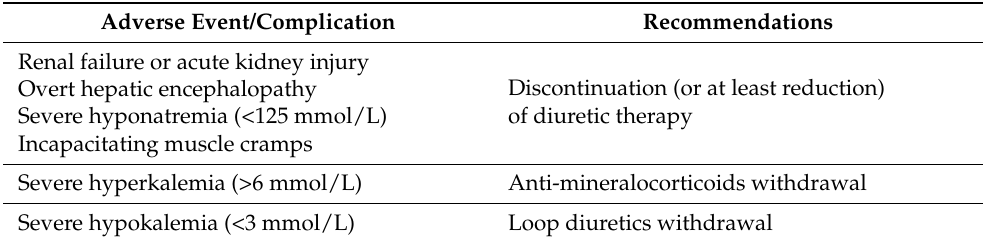
Table 1. Complications and adverse events related to diuretic therapy and recommendations on diuretics management according to major international guidelines